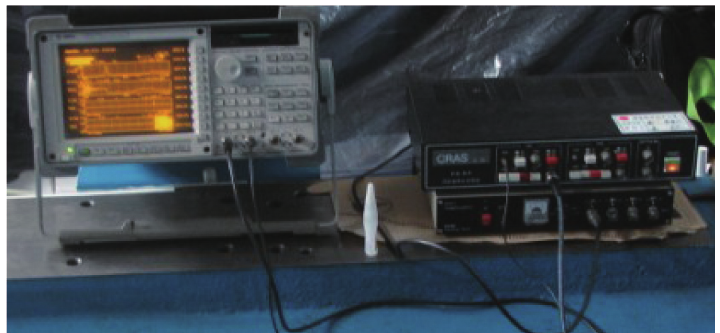
Fig. 15. Dynamic signal